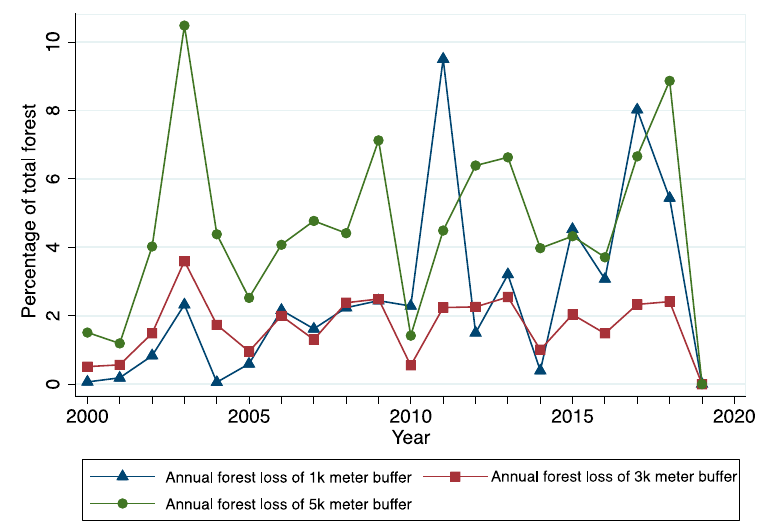
Figure 9. Yearly deforestation rate for Village A in 1000-, 3000-, and 5000-m buffers, 2000–2019.